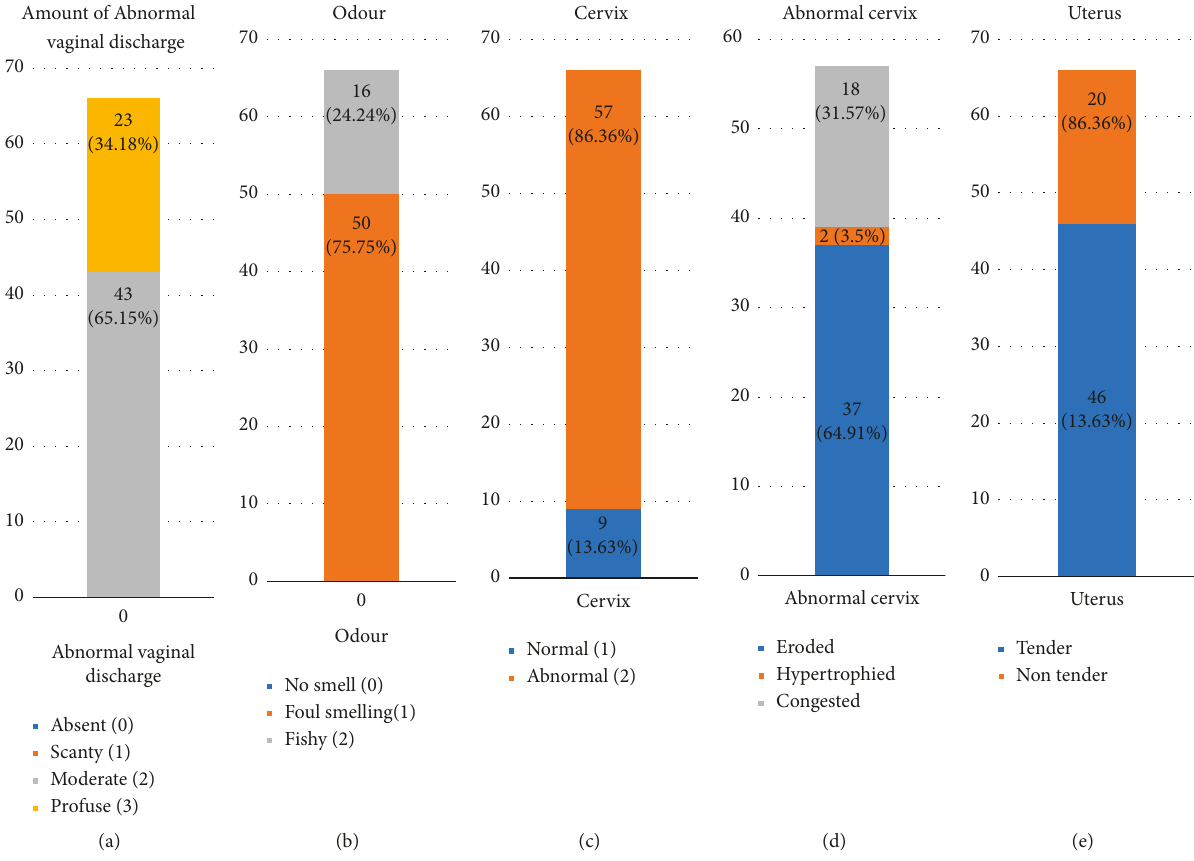
Figure 5: Clinical examination findings of participants with abnormal vaginal discharge. (a) Abnormal vaginal discharge. (b) Odour. (c) Cervix. (d) Abnormal cervix. (e) Uterus.